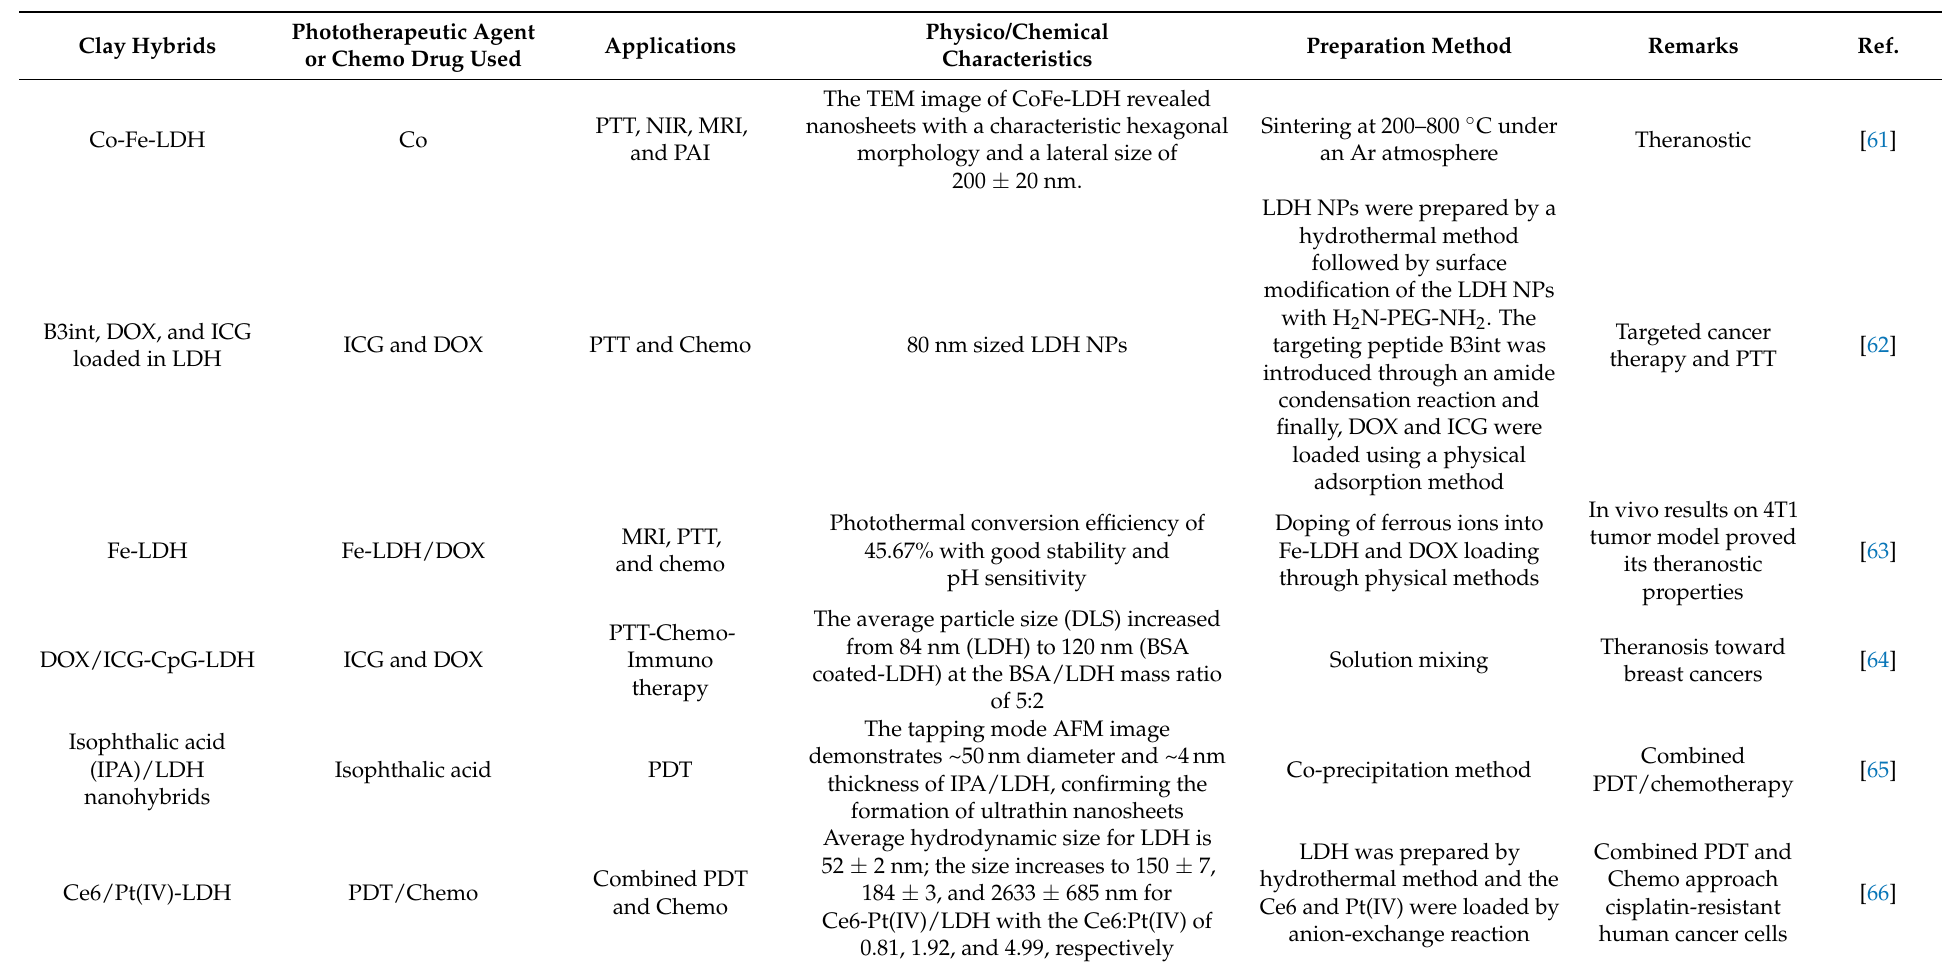
Table 1. Various clay-based bio-inorganic nanohybrids in photothermal, photodynamic, photothermal/photodynamic, and chemo-combination